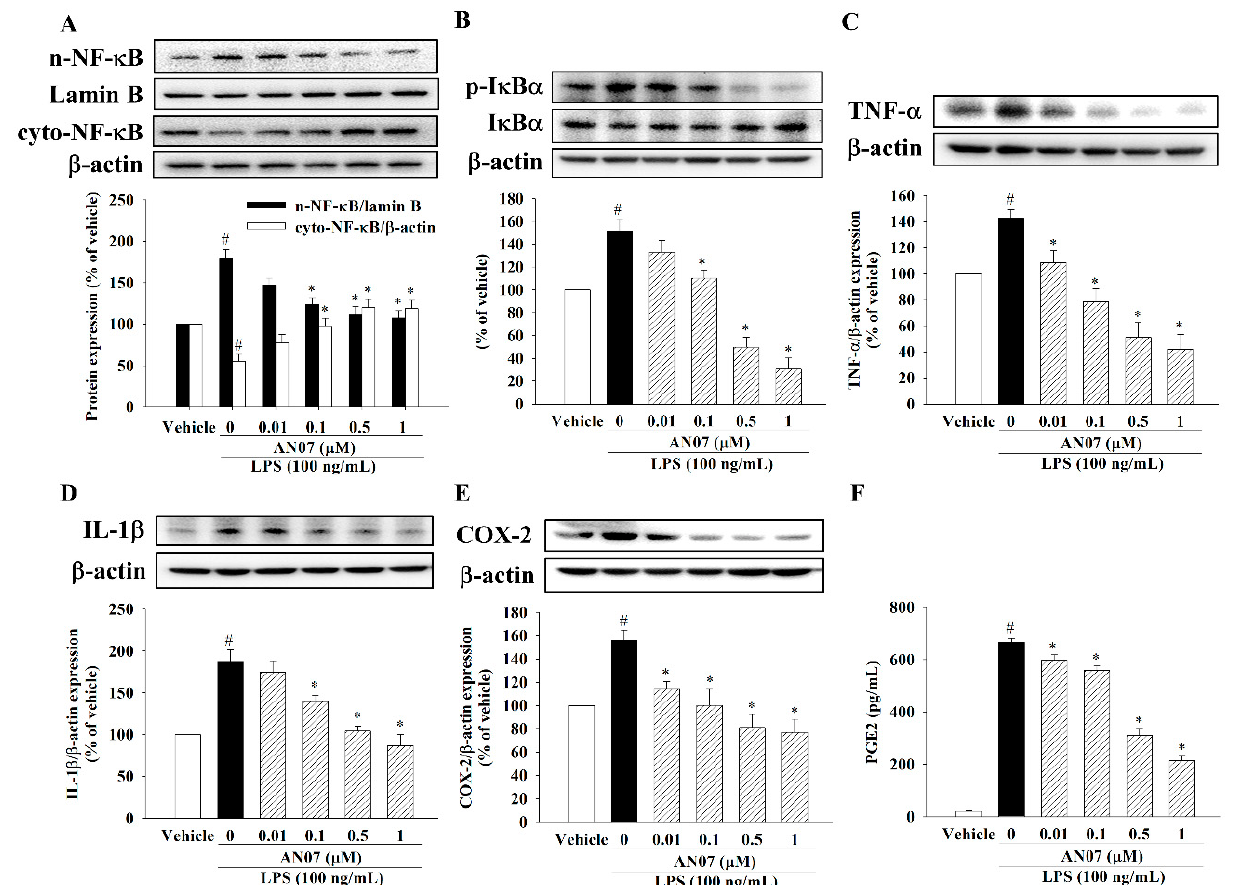
Figure 5. AN07 attenuated LPS-induced inflammatory signaling in C2C12 myotubes. Myotubes were pretreated with AN07 (0.01–1 µ M) for 1 h followed by LPS (100 ng/mL) treatment for 2 h. The protein expressions of ( A ) nuclear (n-) and cytosolic (cyto-) NF κ Bp65, ( B ) p-I κ B α /I κ B α , ( C ) TNF- α , ( D ) IL-1 β , and ( E ) COX-2 were measured by Western blotting. Densitometry analyses are presented as the relative ratio of protein/ β -actin or lamin B and are represented as percentages of the control group. ( F ) For measuring PGE2 levels, myotubes were pretreated with AN07 (0.01–1 μ M) for 1 h followed by LPS (100 ng/mL) treatment for 24 h. Then, the culture media were collected for measuring PGE2 levels by ELISA assay. Data represent the mean ± SEM from six independent experiments (n = 6). # p < 0.05 vs. control group (vehicle only); * p < 0.05 vs. LPS-treated group according to Kruskal–Wallis test followed by Dunn’s test ( A – E ) or one-way ANOVA followed by a Tukey post-hoc test ( F ).